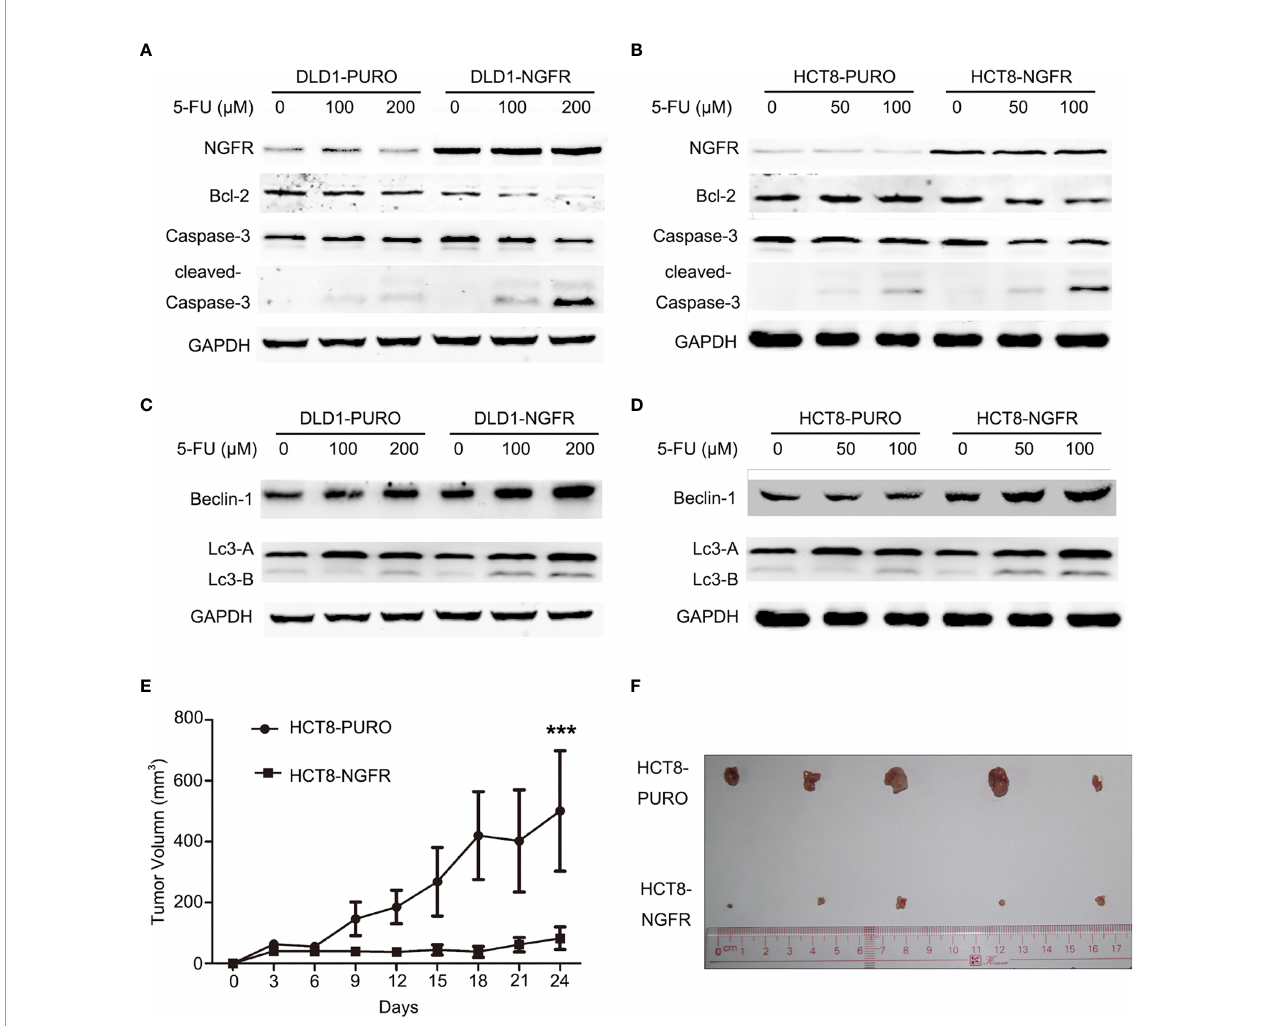
FIGURE 4 | NGFR overexpression enhanced 5-FU-induced apoptosis and autophagy of CRC cells. Apoptosis markers (Bcl-2, caspase-3, and cleaved caspase-3) were detected in (A) DLD1 and (B) HCT8 cells treated with 5-FU (0, 100, and 200 µ M for DLD1 cells; 0, 50, and 100 µ M for HCT8 cells) for 48 h by western blot. Autophagy markers (Beclin-1, LC3A [upper band], and LC3B [lower band]) were detected in (C) DLD1 and (D) HCT8 cells treated with 5-FU (0, 100, and 200 µ M for DLD1 cells; 0, 50, and 100 µ M for HCT8 cells) for 48 h by western blot. The role of NGFR in tumor suppression of CRC with 5-FU-based therapy was investigated in vivo . The tumor (E) volume and (F) size of a xenograft mouse model in overexpressed NGFR – transfected HCT8 cells were smaller than those with empty vector – transfected HCT8 cells after 5-FU treatment (t-test; ***P <